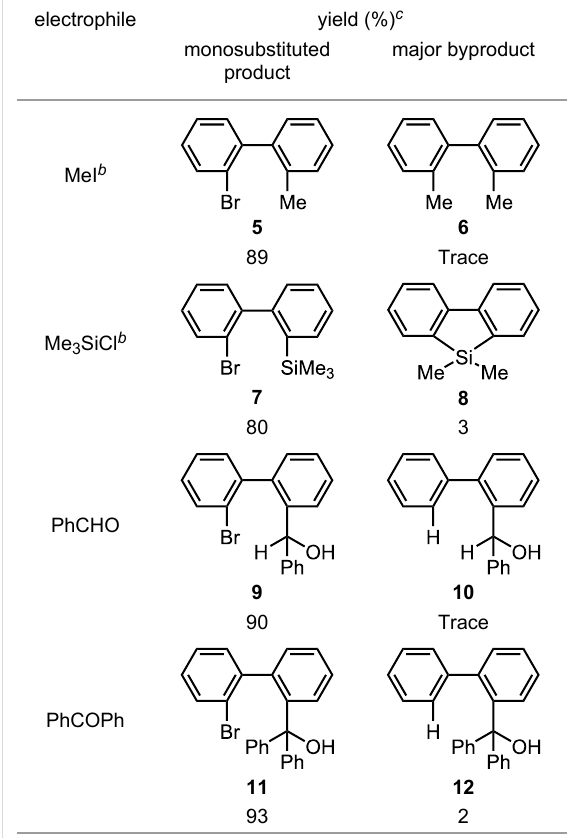
electrophile yield (%) c monosubstituted major product